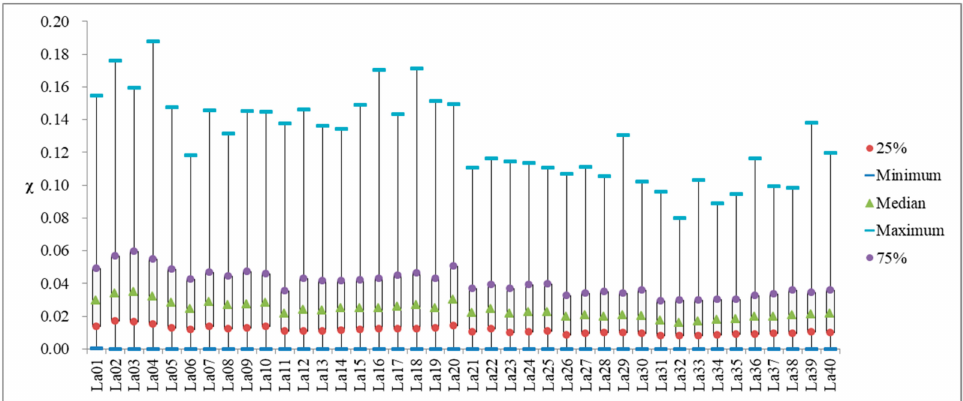
Figure 4. The quartile graph of the absolute relative deviation χ ( ∆ a c , ∆ sim c ) in the problem set